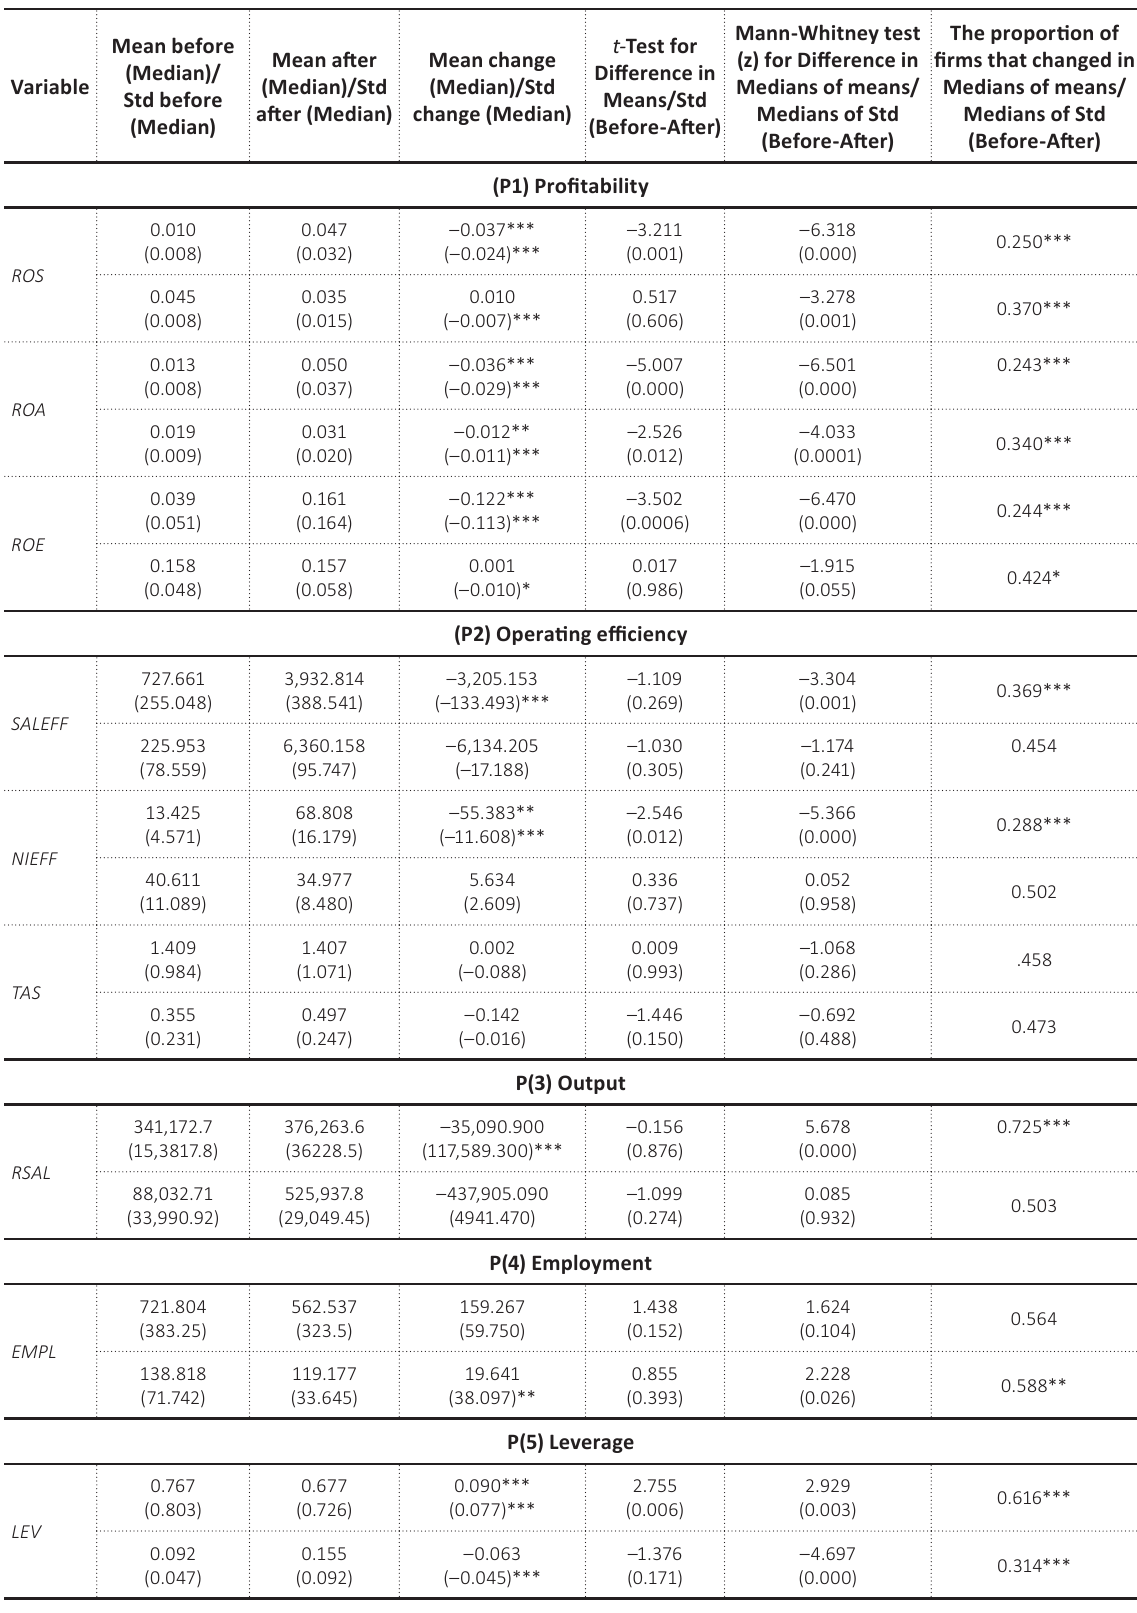
Table A7. Performance changes of large SOEs after privatization (privatized SOEs with tax incentives)